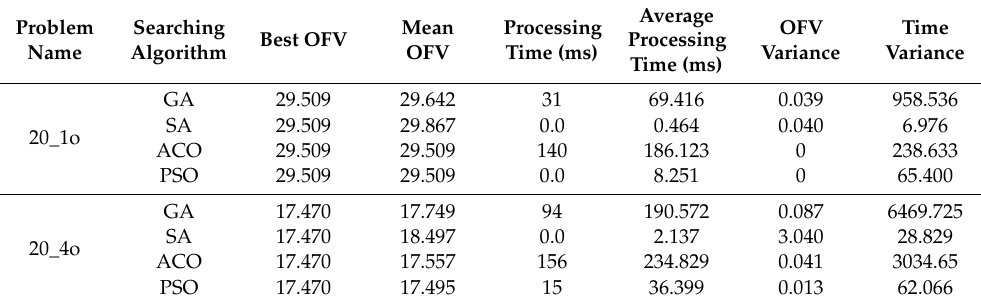
Table 12. Experimental results of the metaheuristic algorithms within 20 × 20 case.